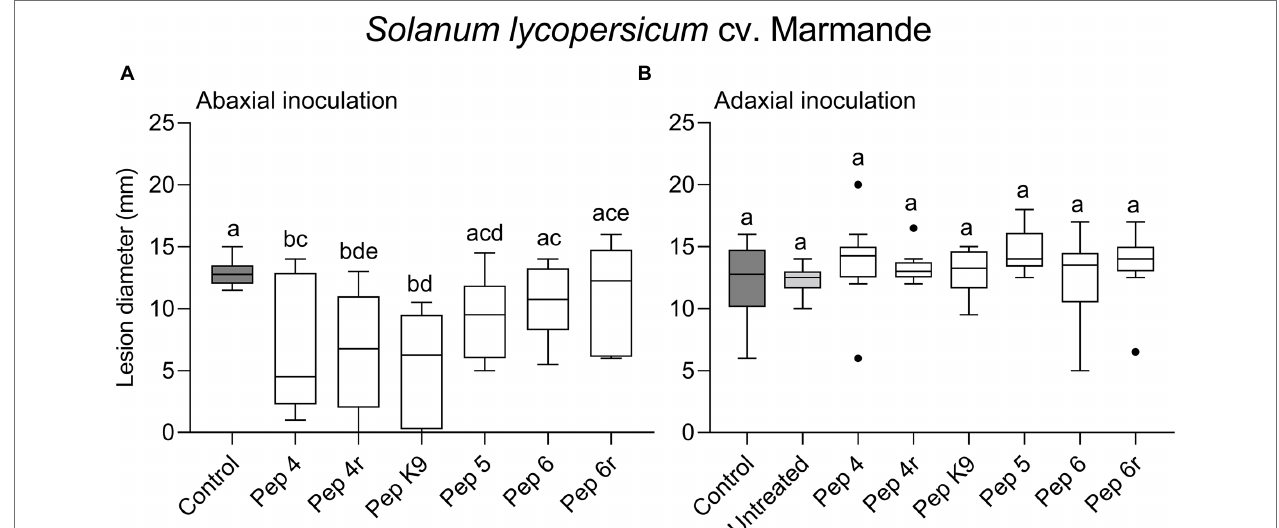
FIGURE 1 | Preventive efficacy of Trichogin GA IV-derived peptides against Botrytis cinerea infection on Solanum lycopersicum cv. Marmande leaves. Treatments were performed on the lower (abaxial) surface by spraying 50 μ M peptide solution in water (A) , or in 0.01% v/v of surfactant Silwet L-77 AG (B) . The pathogen was inoculated 48 h later by drop inoculation with a conidial suspension of B. cinerea . Conidia were applied on the abaxial (peptide-treated; A ) or adaxial (untreated; B ) leaf surface. Lesion diameters were measured 3 days after infection. Control leaves were treated with water (A) or water containing 0.01% Silwet L-77 (B) . Values from 12 biological replicates (A) or 9–14 biological replicates (B) are reported as Tukey boxplots. Data were analyzed by one-way ANOVA with Tukey–Kramer post- test ( p < 0.05). Statistically significant differences are shown by different